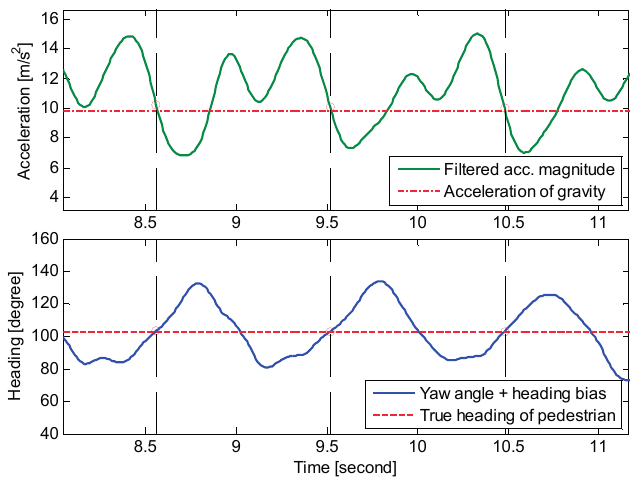
Figure 12. True heading of pedestrian acquired based on acceleration magnitude characteristics during walking.